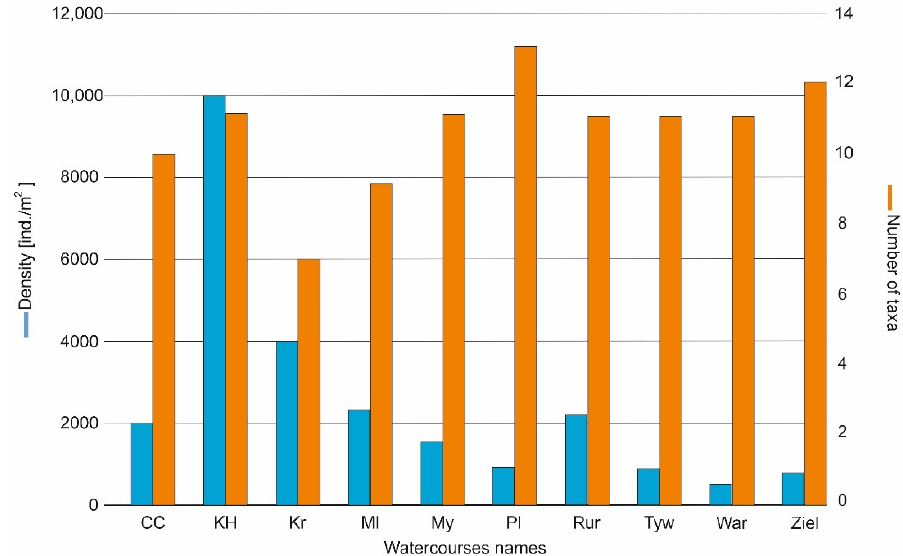
Figure 3. Number of taxa and density (ind./m 2 ) of the surveyed sites.